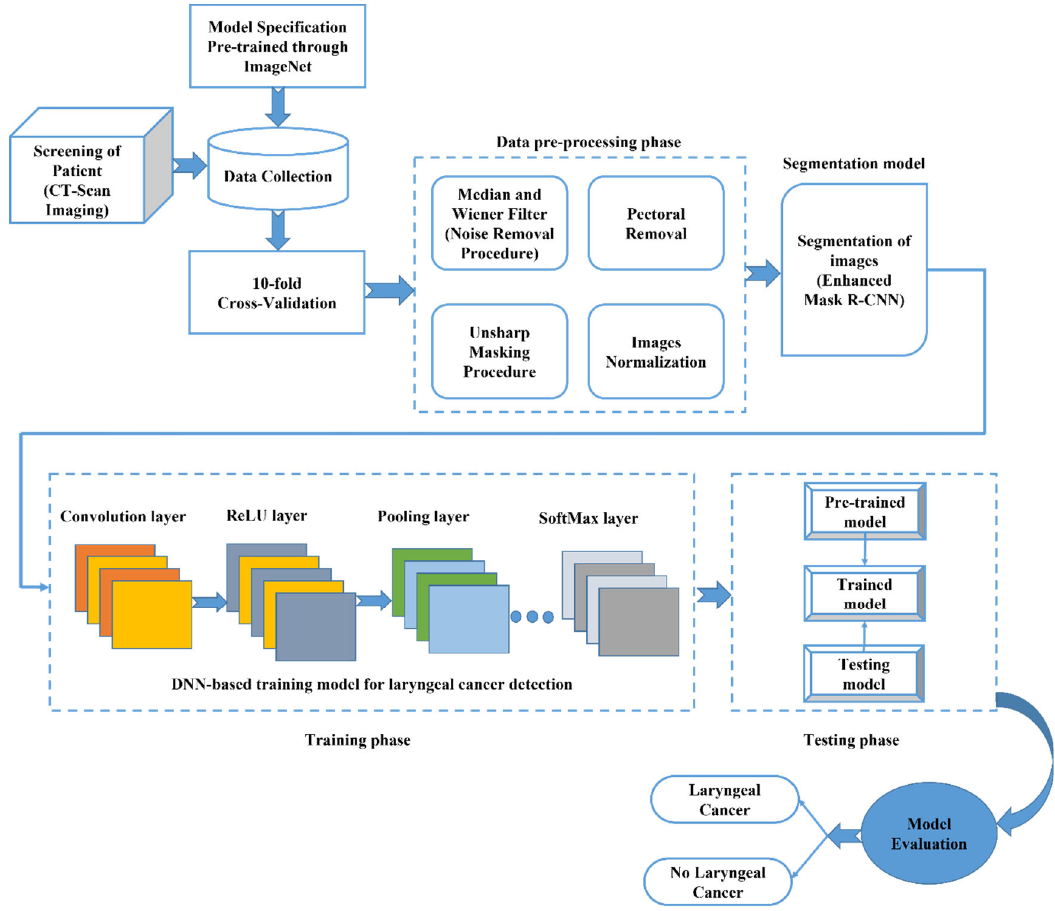
Figure 4. Proposed IML ‐ CNN model for the assessment of laryngeal cancer using image datasets.